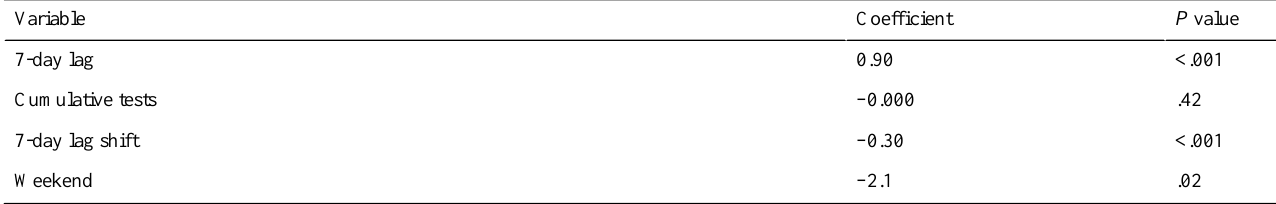
P valueCoefficientVariable